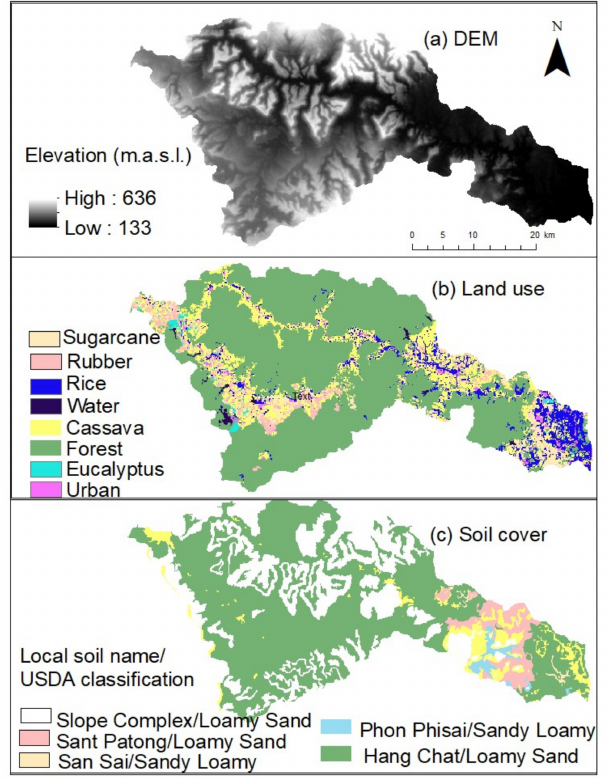
Figure 3. ( a ) DEM, ( b ) land-use, and ( c ) soil cover maps of the Huai Bang